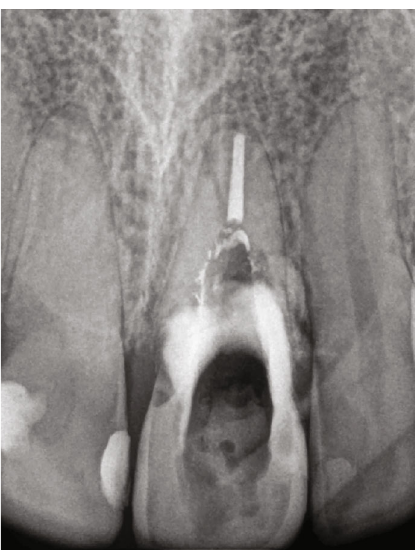
Figure 2: GI subgingival “ Imam matrix ” that sealed the resorptive root